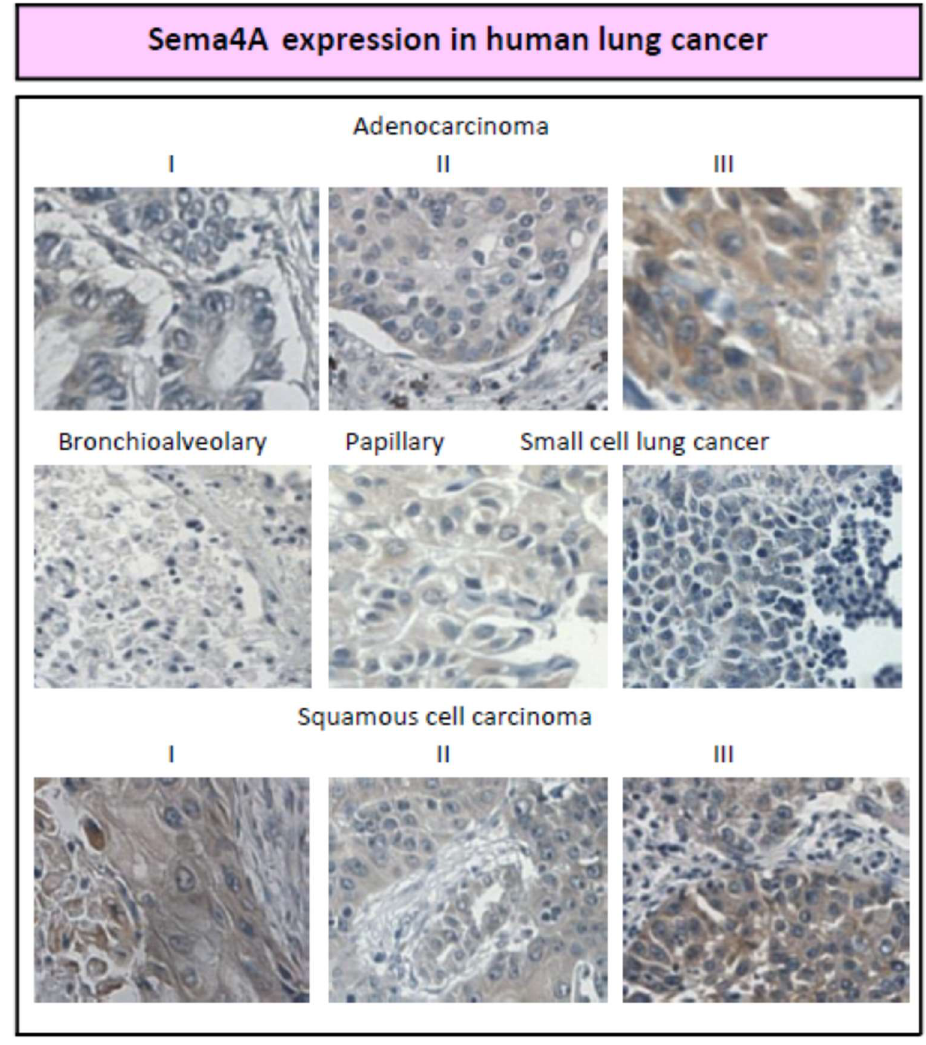
Figure 4. Immunohistochemistry of human lung cancerous tissue arrays (BioChain) was visualized via a four-step staining procedure using anti-Sema4A (sc-46258, Santa Cruz) as primary Ab, biotinylated rabbit anti-goat IgG (sc-2774) as secondary Ab, streptavidin-HRP (Abcam) as detection enzyme, and DAB peroxidase substrate kit (SK-4100, Vector) for visualization (100 × magnification). The stages of cancer are shown in Roman numerals. Staining specificity was compared with goat IgG control Ab stain (not shown).